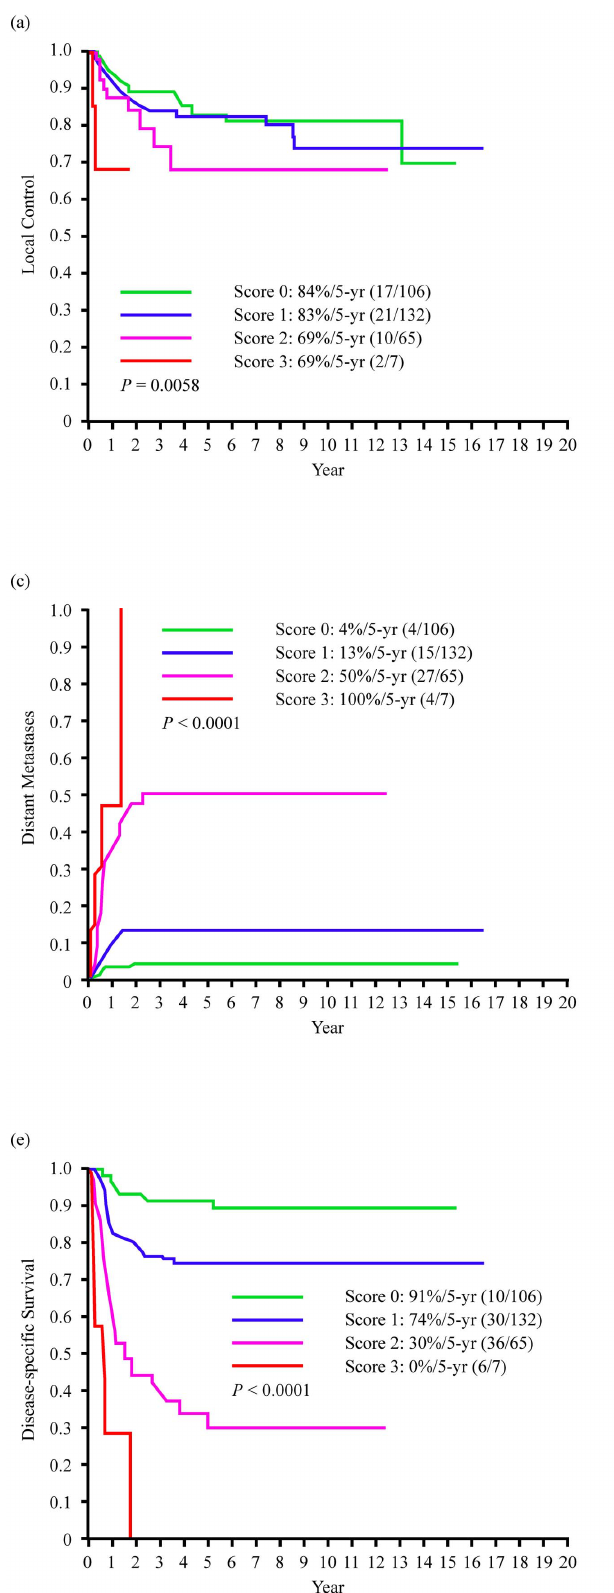
Figure 1. Kaplan-Meier estimates of 5-year outcome in the segmental mandibulectomy patients stratified by level IV/V metastases, extracapsular spread status and tumor depth of $ 15 mm, (a) local control, (b) neck control, (c) distant metastases, (d) disease-free survival, (e) disease-specific survival, (f) overall survival.